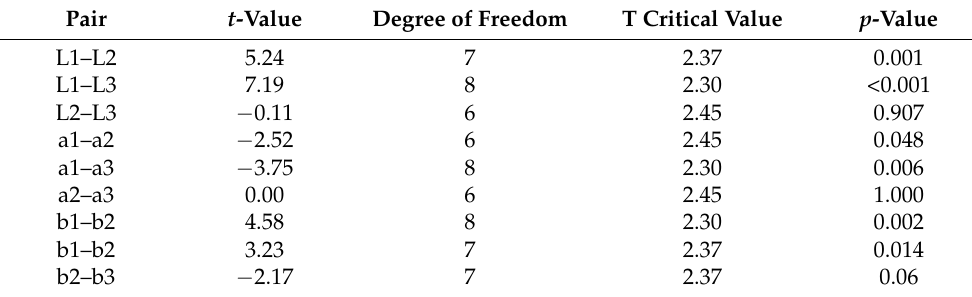
Table 3. Two-sample t -test of color coordinate pairs in relation to pressing times.